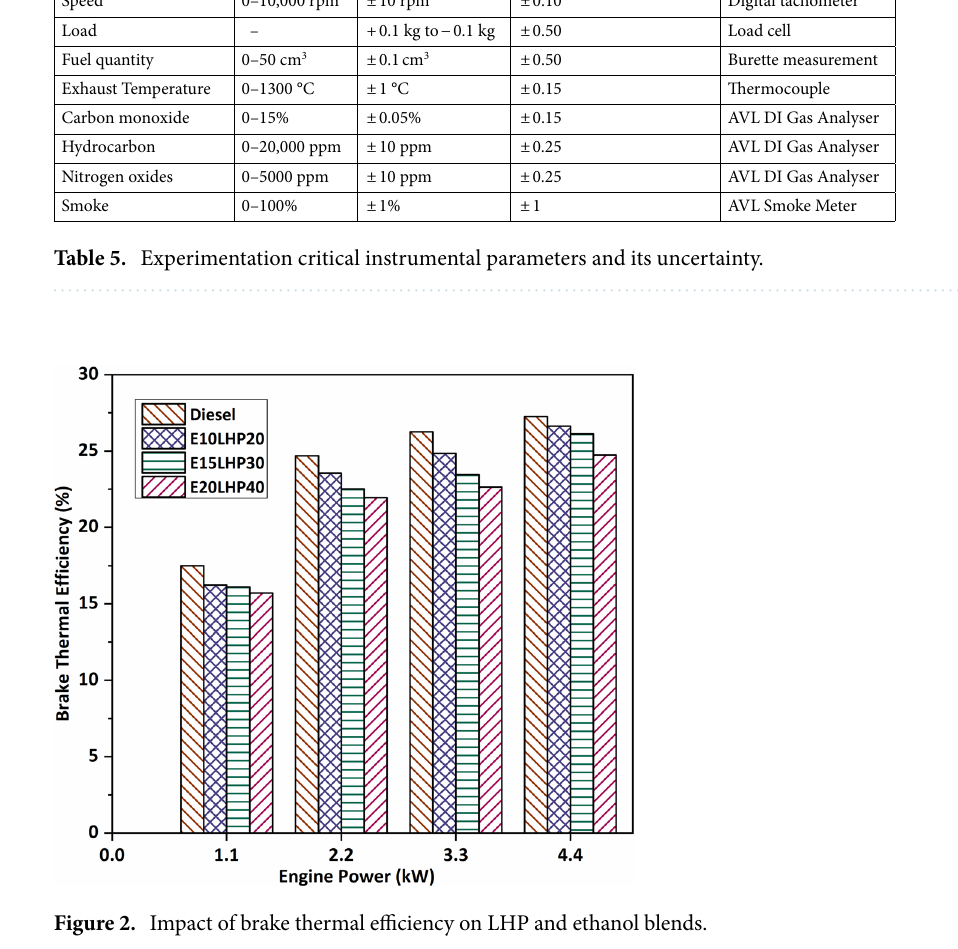
Figure 2. Impact of brake thermal efficiency on LHP and ethanol